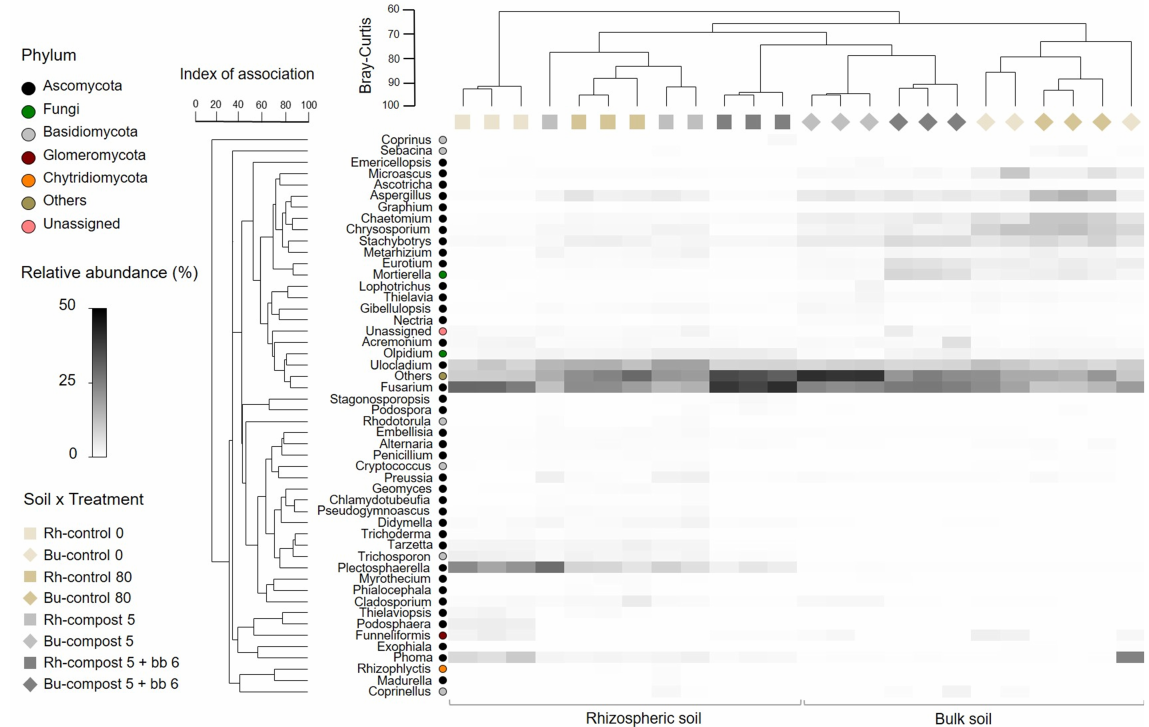
Figure 8. Heat plot showing the relative abundance of the 50 most frequent taxa in the fungal community. In the column legend, the same color and shape indicate replicates of the same treatment and the same type of soil (Rh, rhizospheric; Bu,